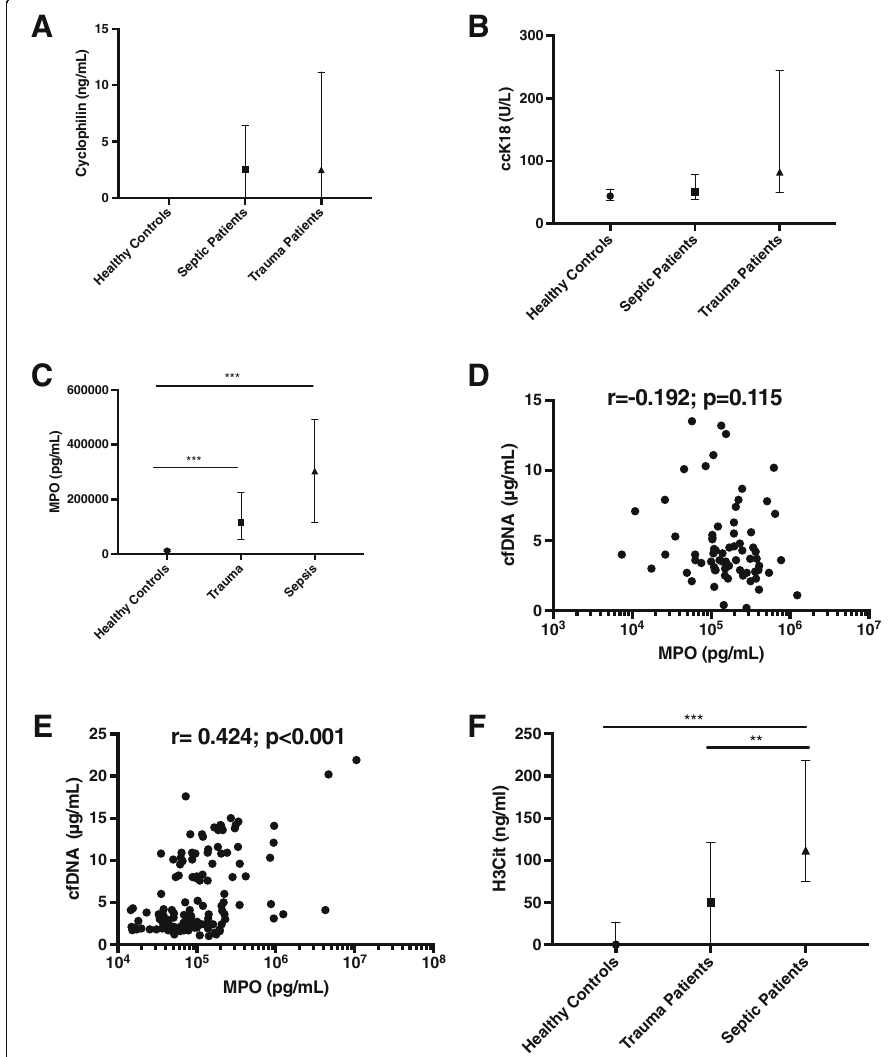
Fig. 2 Investigations into the potential sources of cfDNA. a Necrosis as quantified by levels of cyclophilin A. b Apoptosis as quantified by ccK18 fragments. c Day 1 MPO levels in sepsis, trauma, and healthy controls. d Correlation between myeloperoxidase (MPO) and cell-free DNA (cfDNA) in trauma patients. e Correlation between MPO and cfDNA levels in septic patients. f Levels of citrullinated histone H3 in sepsis, trauma, healthy controls. Note: *** p < 0.001, ** p < 0.01; data represent median and interquartile